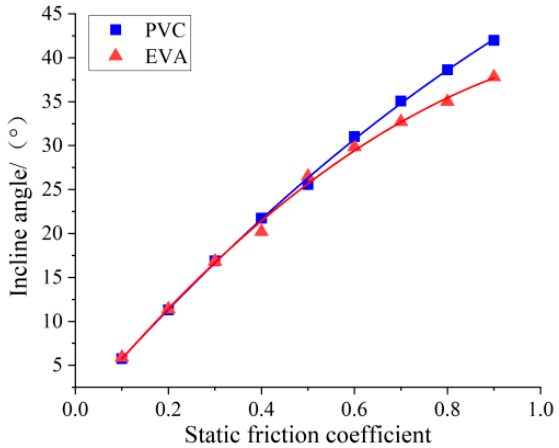
Figure 11. Fitting curve of static friction coefficient and inclination angle.